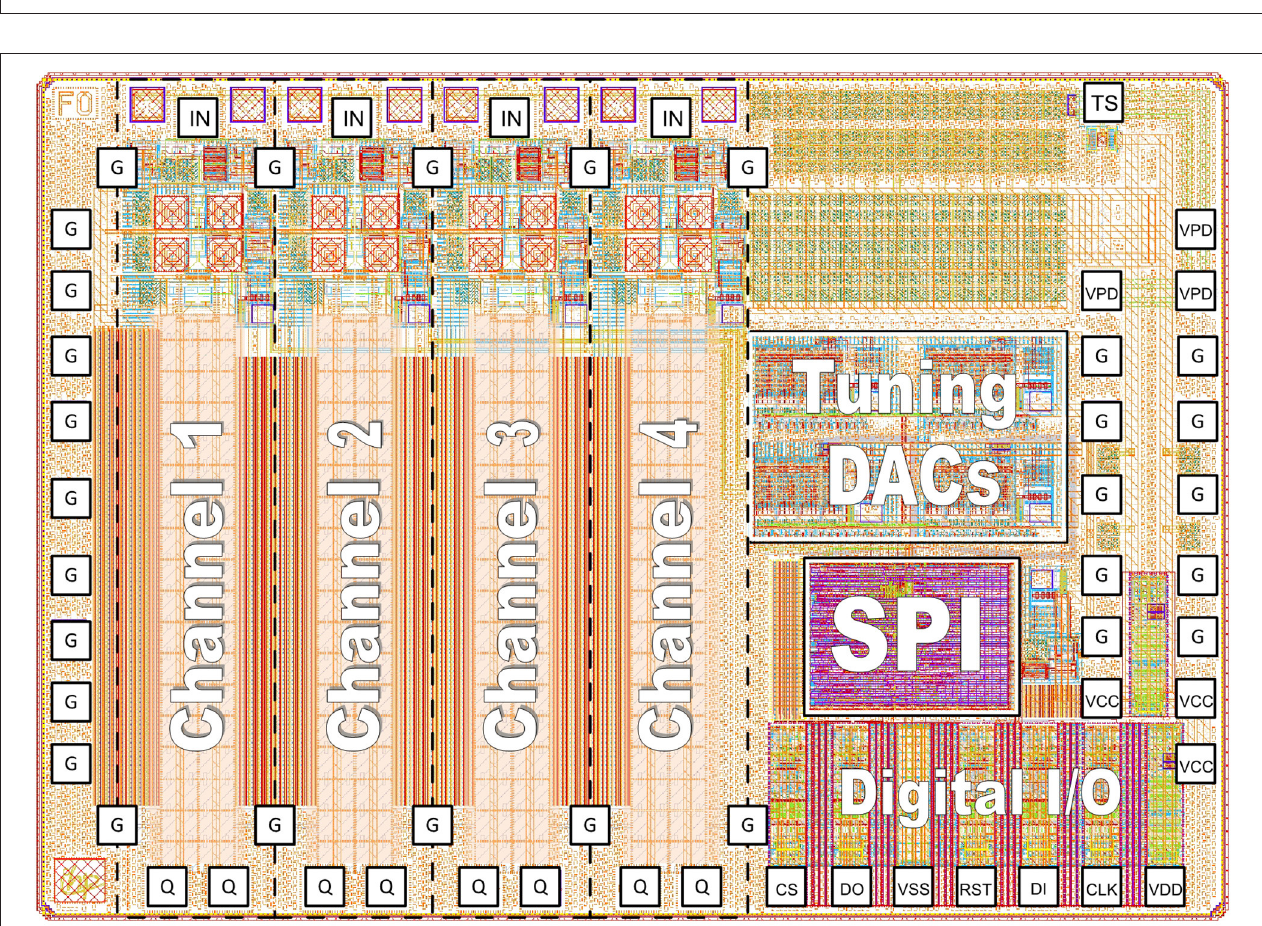
FIGURE 14 | Differential eye diagrams at the module output including TIA post layout simulation.